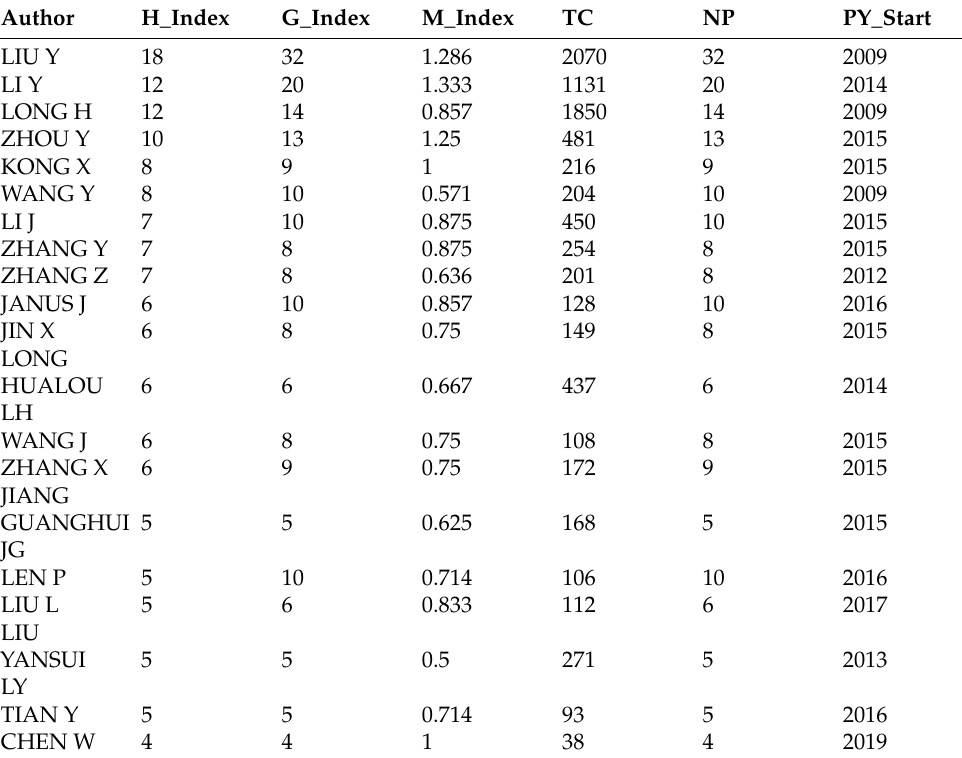
Table 1. Top 20 influential authors in the field of land consolidation and rural revitalization from 1950 to 2021.